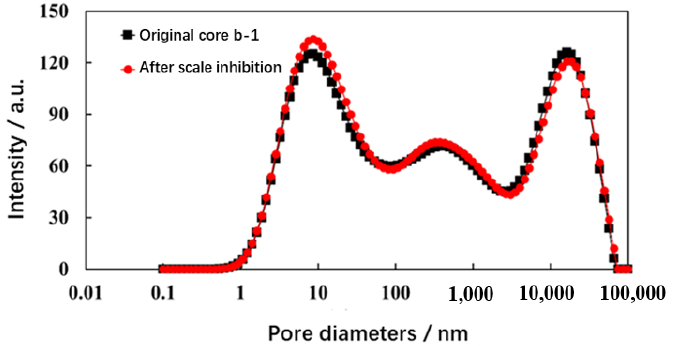
Figure 9. NMR curve of propped core b-2 before and after scaling with scale-inhibitor fracturing fluid.